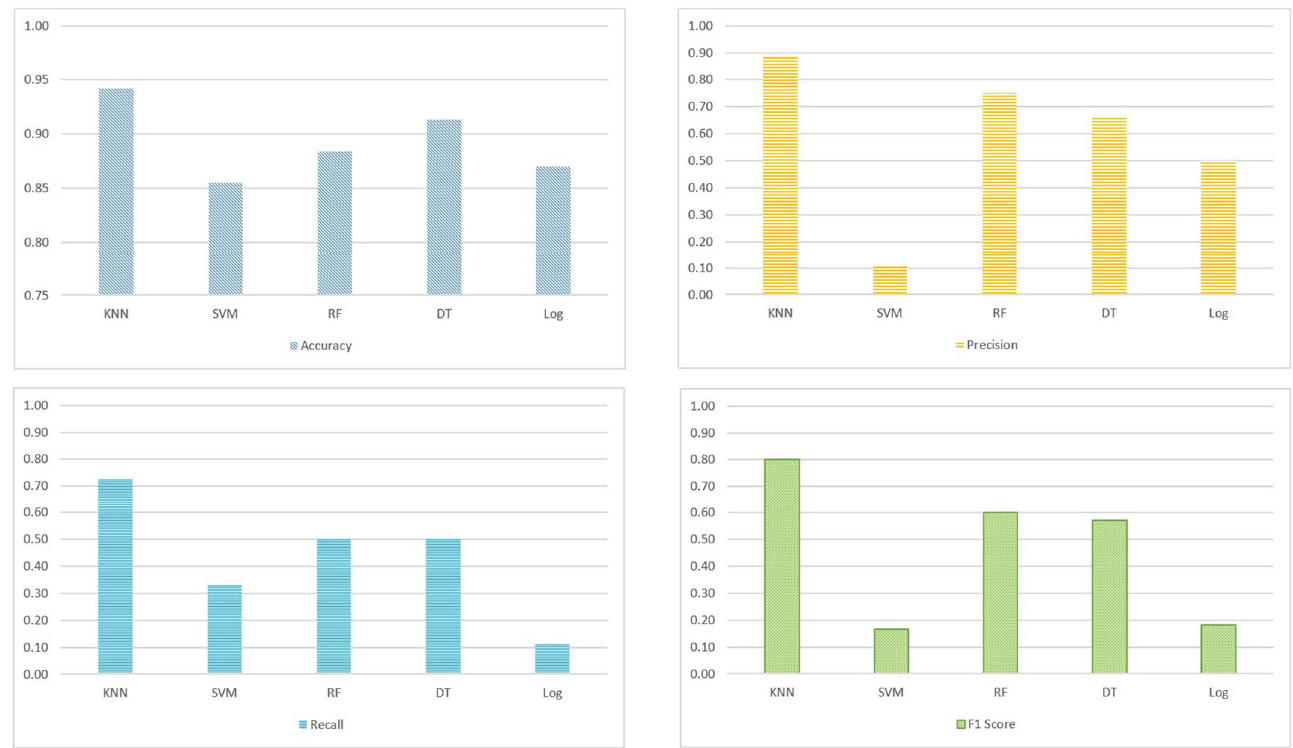
Figure 6. Comparative performance results of the multi-label task selection algorithm (Algorithm 1) using the best classifier (KNN, SVM, RF, DT, and LogR). Analyzed metrics include accuracy, precision, recall, and F1 score.